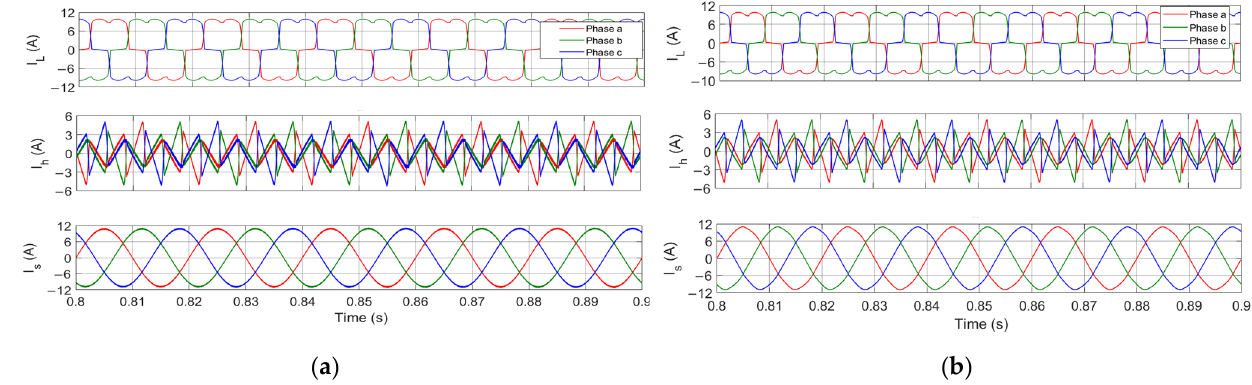
Figure 6. Waveforms of I L , I h , and I s ( a ) using PQ extraction ( b ) using SRF extraction.